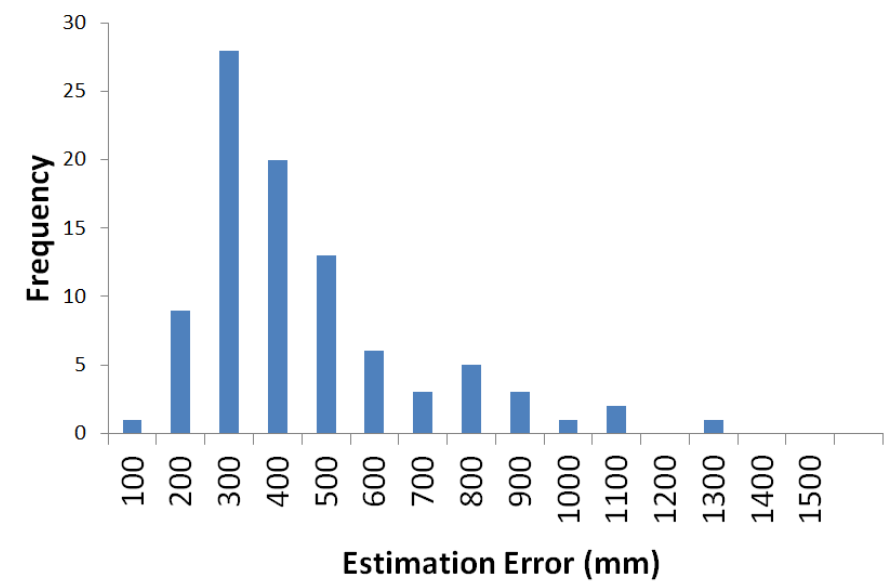
Figure 6. Histogram of estimation error of IMES radio-based